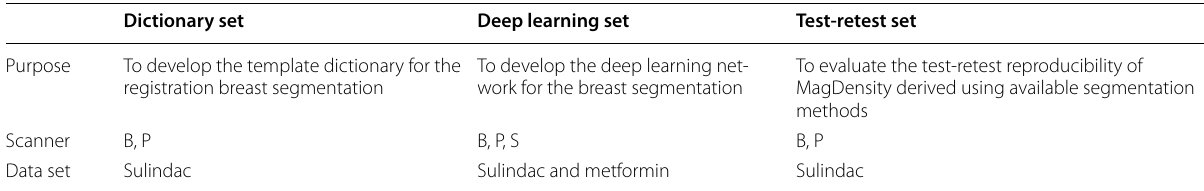
Table 1 Summary characteristics of the data used in different